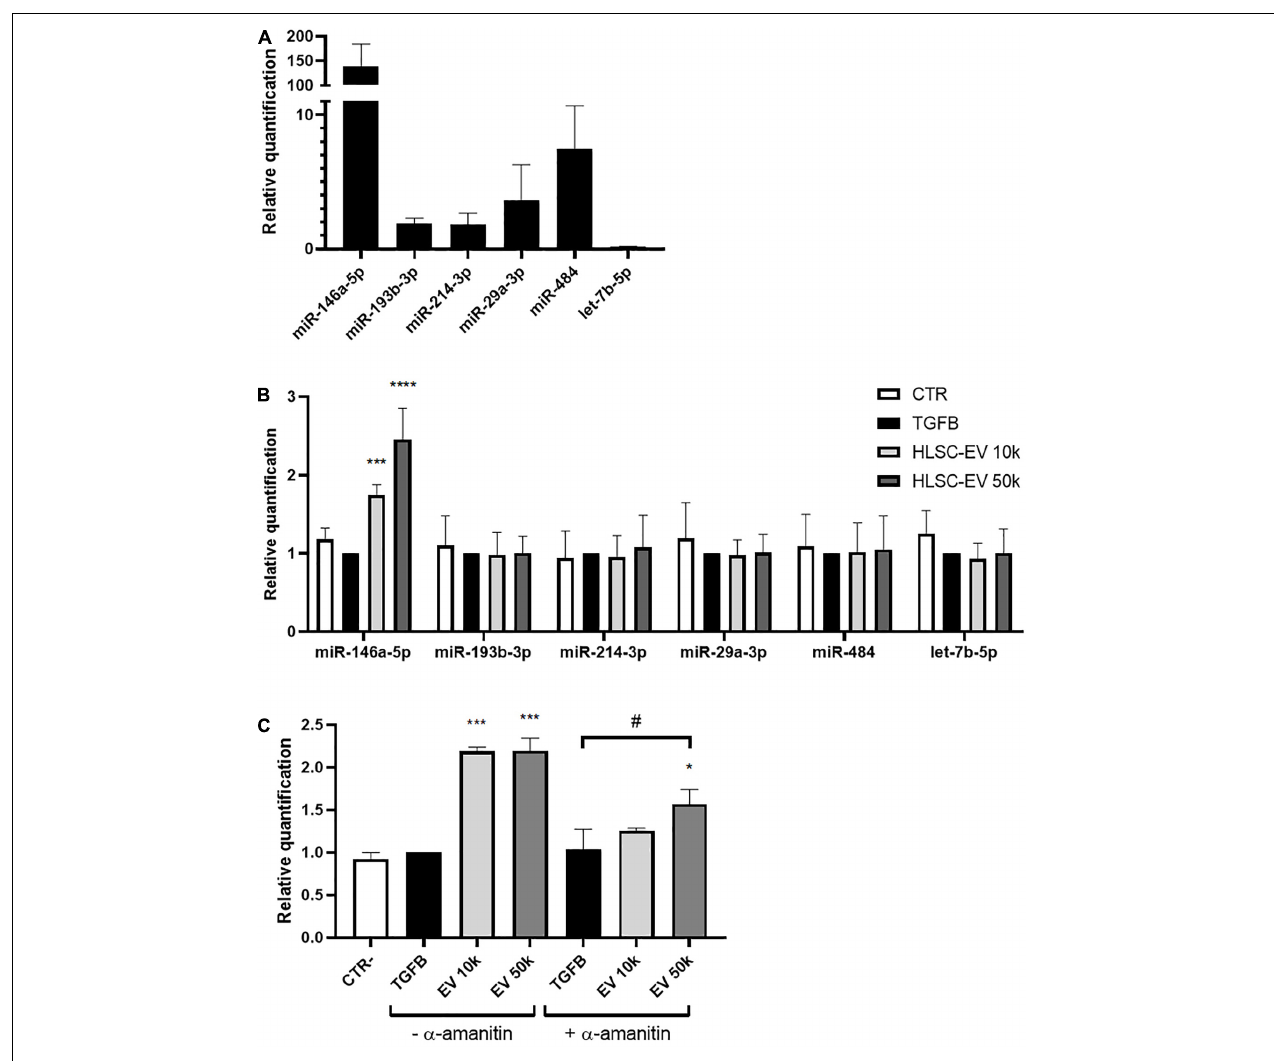
FIGURE 5 | Expression of selected miRNAs in HLSC-EVs and in activated LX-2 stimulated with HLSC-EVs. (A) QRT-PCR validation of the expression in HLSC-EVs of the 6 miRNAs predicted to target α -SMA and COL1A1 mRNA. The miRNA expression levels in MSC-EVs were used as reference control. (B) QRT-PCR analysis of selected miRNA expression in LX-2 after a 24-h incubation with HLSC-EVs (10–50 k). (C) QRT-PCR analysis of miR-146a-5p expression in LX-2 after a 24-h incubation with HLSC-EVs (10–50 k) in the presence or absence of α -amanitin. MiRNA expression levels were normalized on those of miR-24-3p. LX-2 activated with TGF- β 1 (10 ng/mL) not incubated with EVs were used as reference control. LX-2 cultured without TGF- β 1 were used as negative control (CTR). Statistical analysis was performed on results obtained from three independent experiments using the Two-way ANOVA test: * p < 0.05; *** p < 0.001; **** p < 0.0001 vs. activated LX-2; # p < 0.05 vs. activated LX-2 treated with α